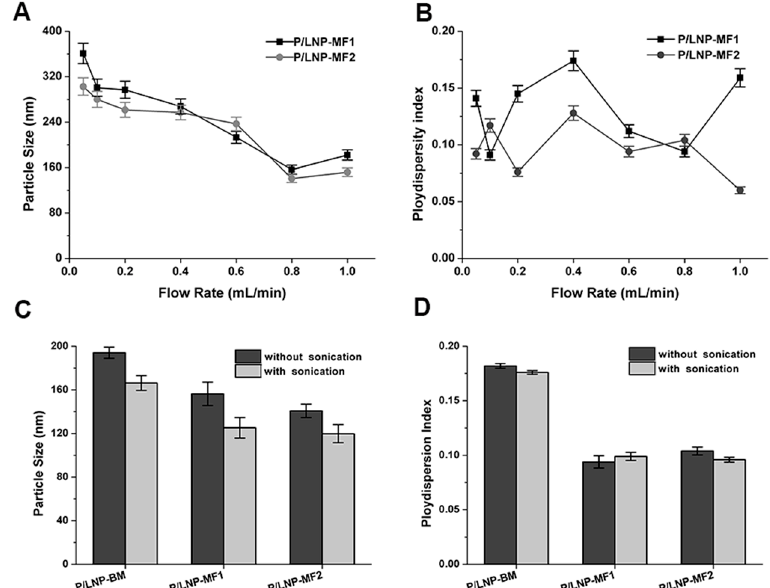
Figure 1. Effects of flow rate and sonication on synthesis of polymer-lipid hybrid nanoparticles (P/LNPs). ( A , B ) Influence of flow rate on particle size and polydispersity index; ( C , D ) Influence of the sonication on particle size and polydispersity index. Error bars indicate standard deviations. ( n = 3).